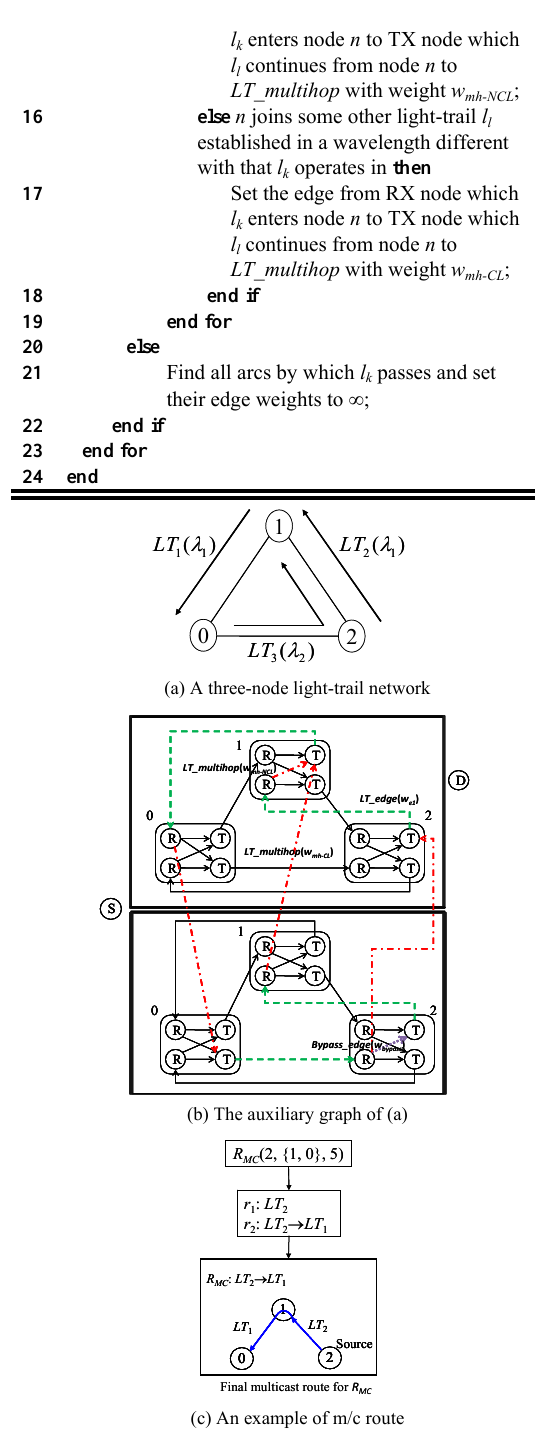
Fig. 5. An example of DLTMR in a light-trail